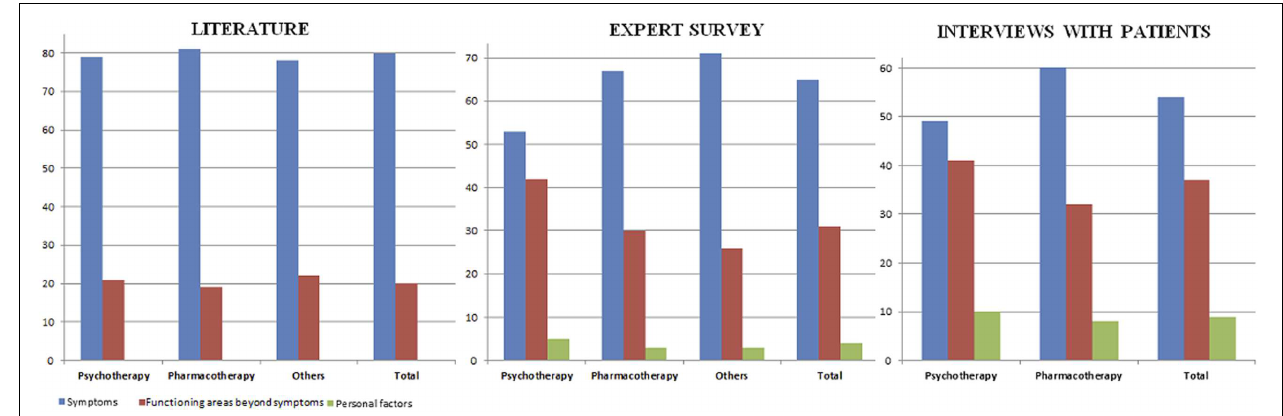
FIGURE 1 | Comparison between the percentages of functioning areas identified in the literature, the expert survey with clinicians, and individual interviews with patients with